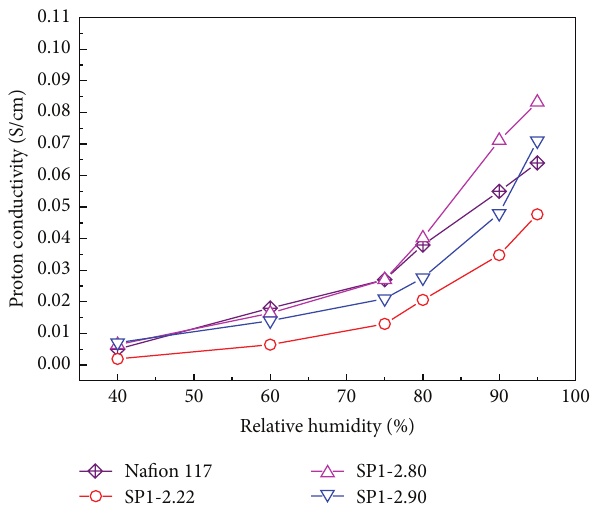
Figure 5: Proton conductivity of SP1- 𝑋 membranes as a function of RH at 30 ∘